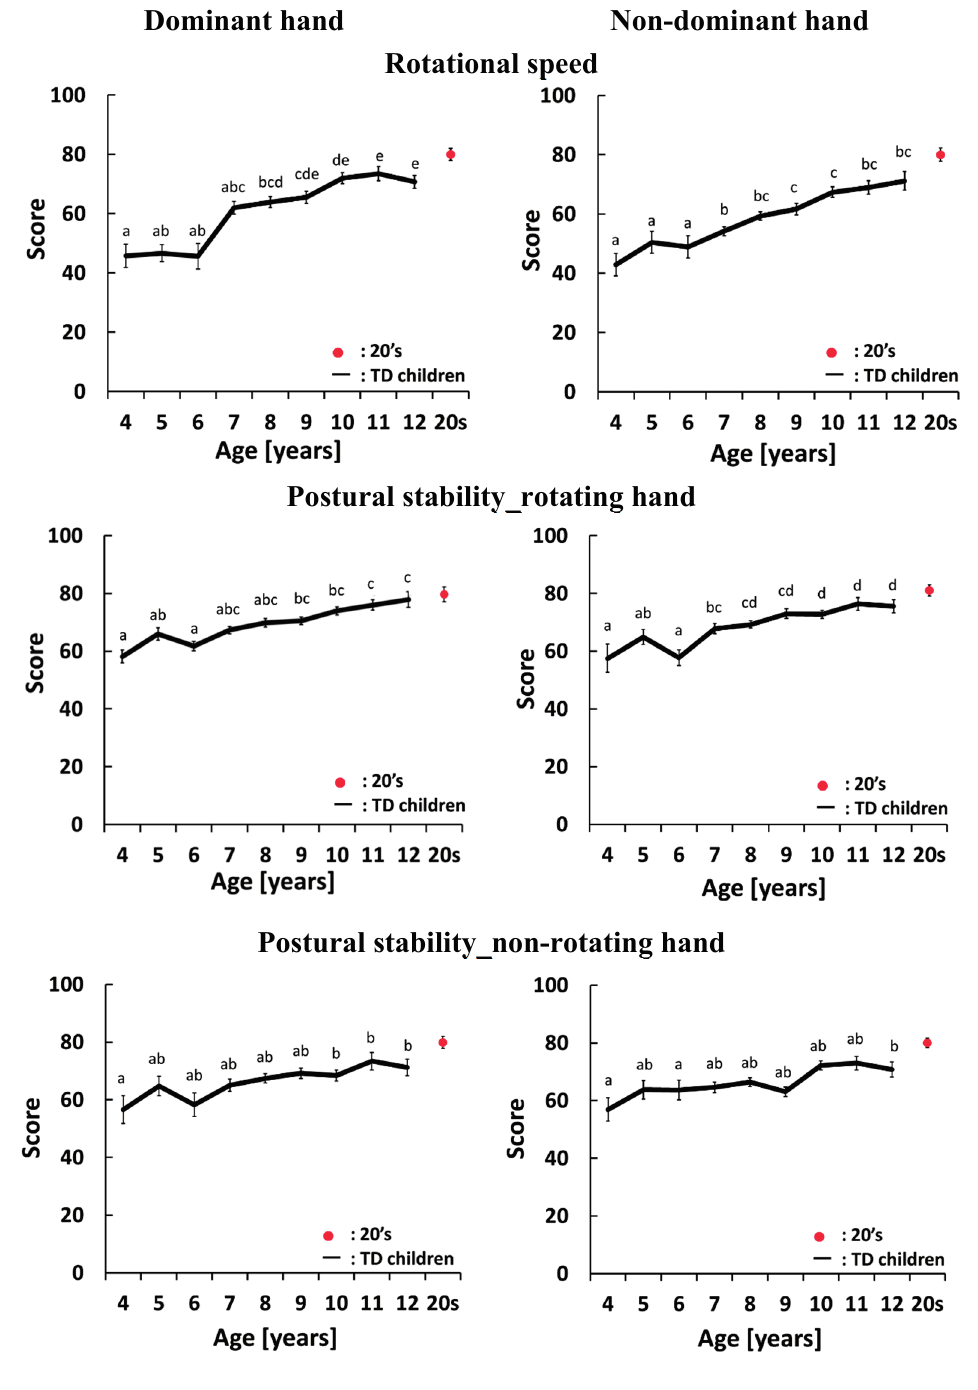
Figure 5. Average and standard error of scores in the maximal-effort motor task performed with one hand. The black line shows the average score for TD children. The red dot shows the average score for participants aged 21–26 years old. There is a significant difference between two different letters which do not include same alphabet on each standard error bars ( p <